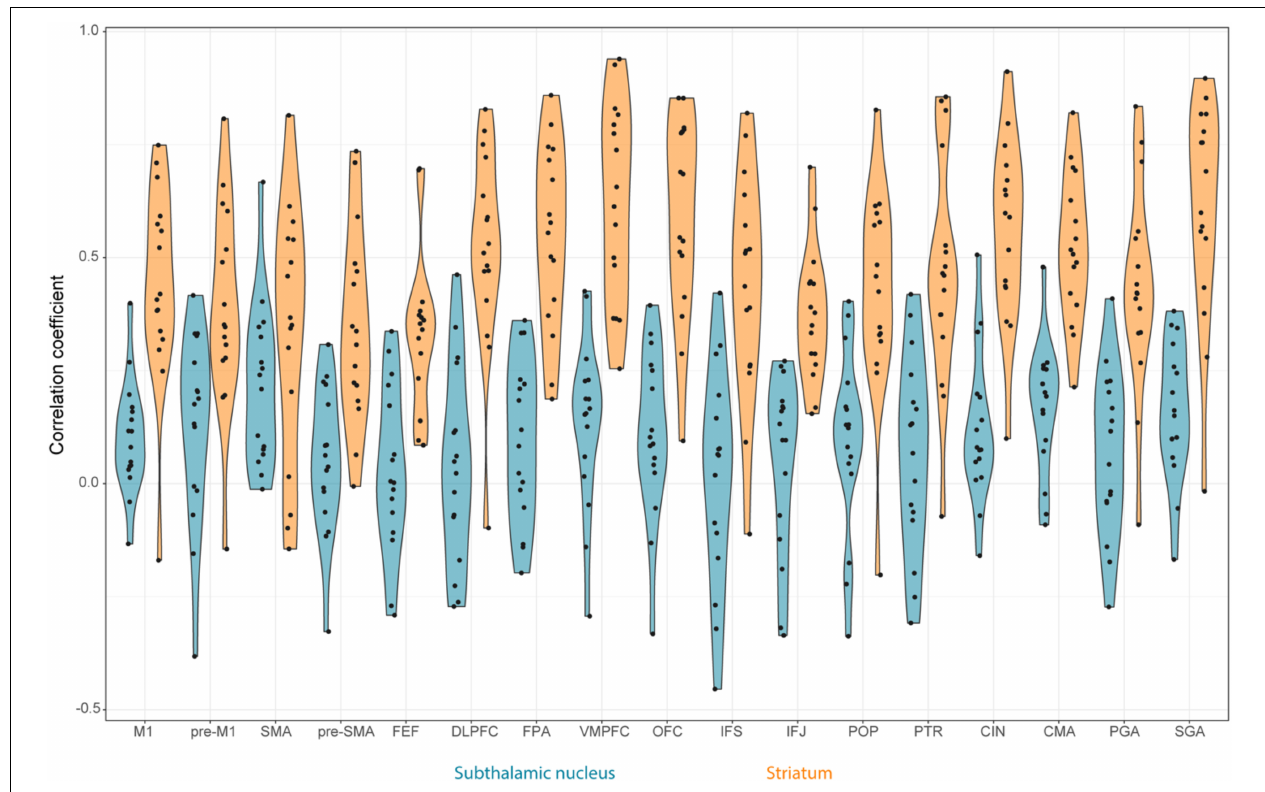
FIGURE 4 | Violin plots of the rs-fMRI correlation between STN, STR, and the different cortical regions per participant. The STN is color coded using blue and the STR using orange. The black circles correspond to the individual participants.